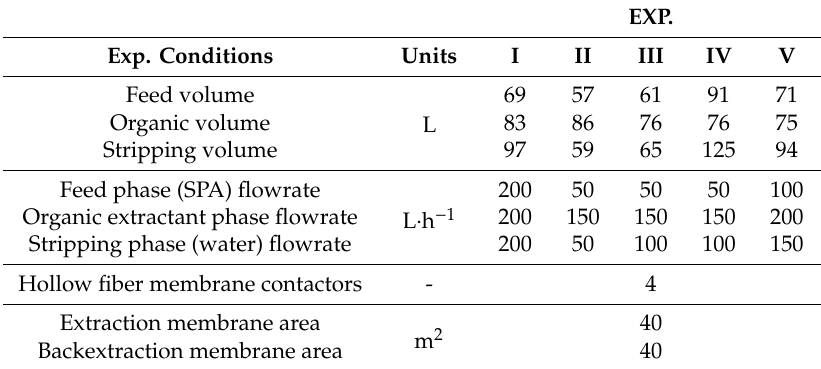
Table 5. Experimental conditions used in the non-dispersive solvent extraction (NDSX) pilot plant tests.